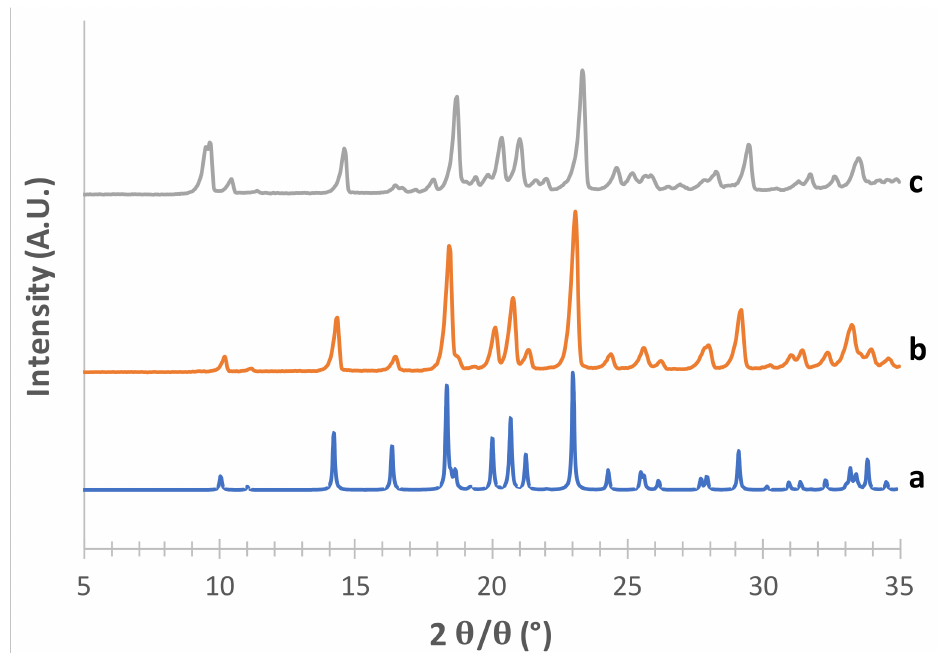
Figure 2. PXRD patterns of mannitol β form (c) obtained using acetone as an antisolvent. (b) By freeze drying technique; (a) CCDC 224659 as a reference.